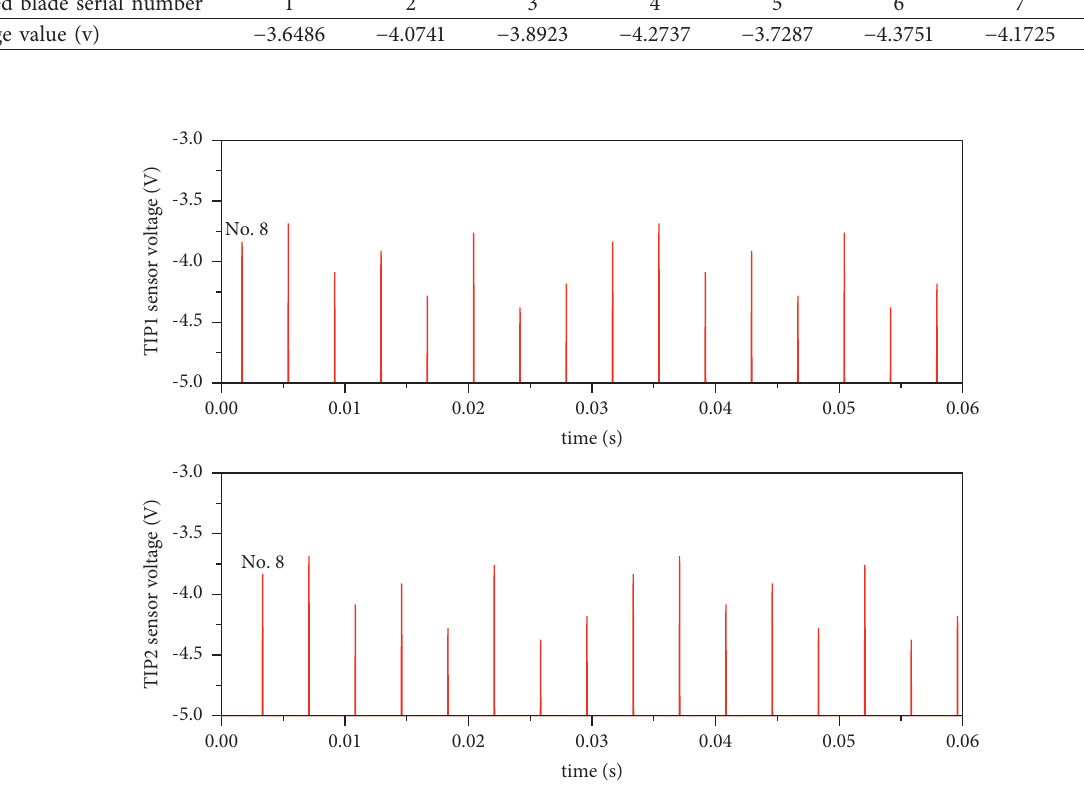
Figure 5: Blade tip-timing vibration testing device of rotating bladed disk system. (a) Vibration test bench. (b) Signal acquisition and processing Table 3: Measured voltage value corresponding to the blade tip clearance under static state. Marked blade serial number